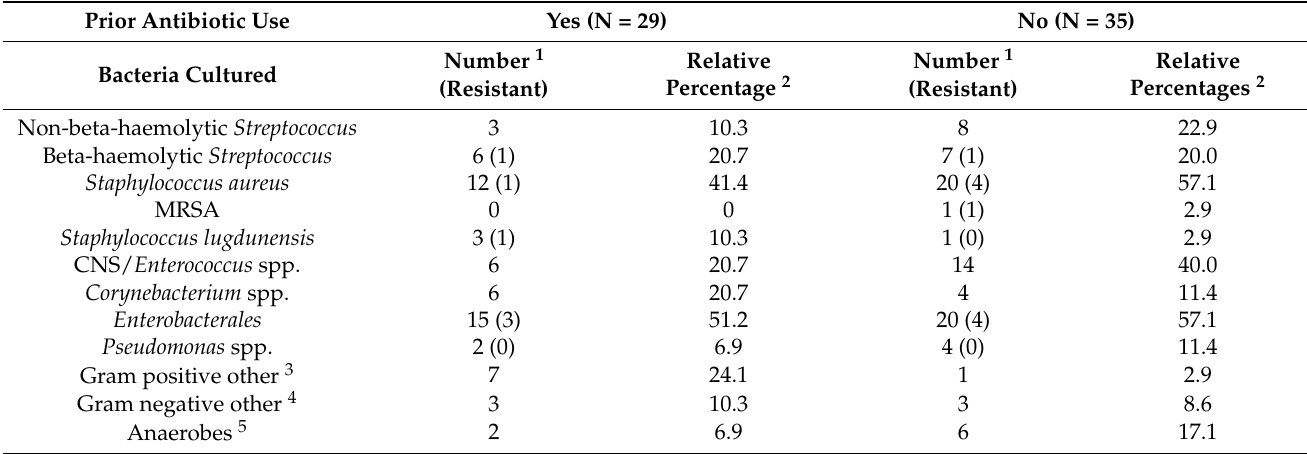
Table 4. Culture results according to prior antibiotic use.